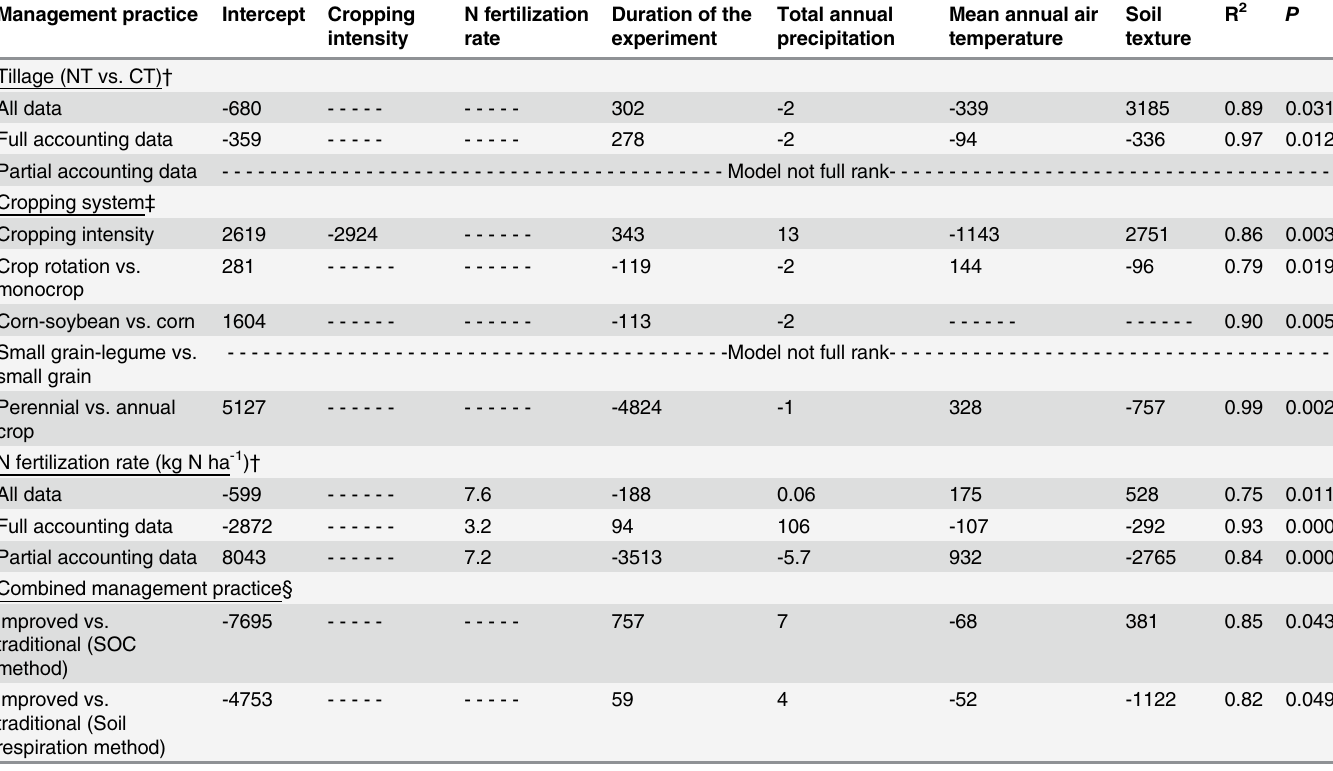
Table 7. Multiple linear regression analysis of net global warming potential (GWP) with management practices, duration of the experiment, total annual precipitation, mean annual air temperature, and soil texture from various locations. Management practice Intercept Cropping